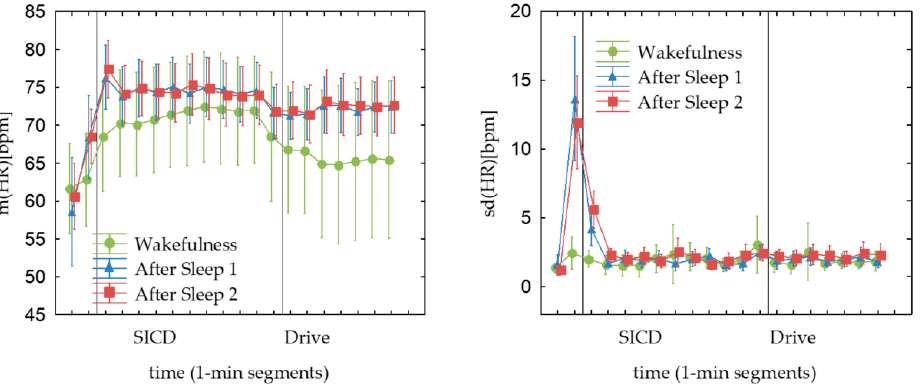
Figure 4. Mean ( left ) and standard deviation ( right ) of heart rate in time segments of 1 min before the SICD, during the SICD and during the successive manual drive.